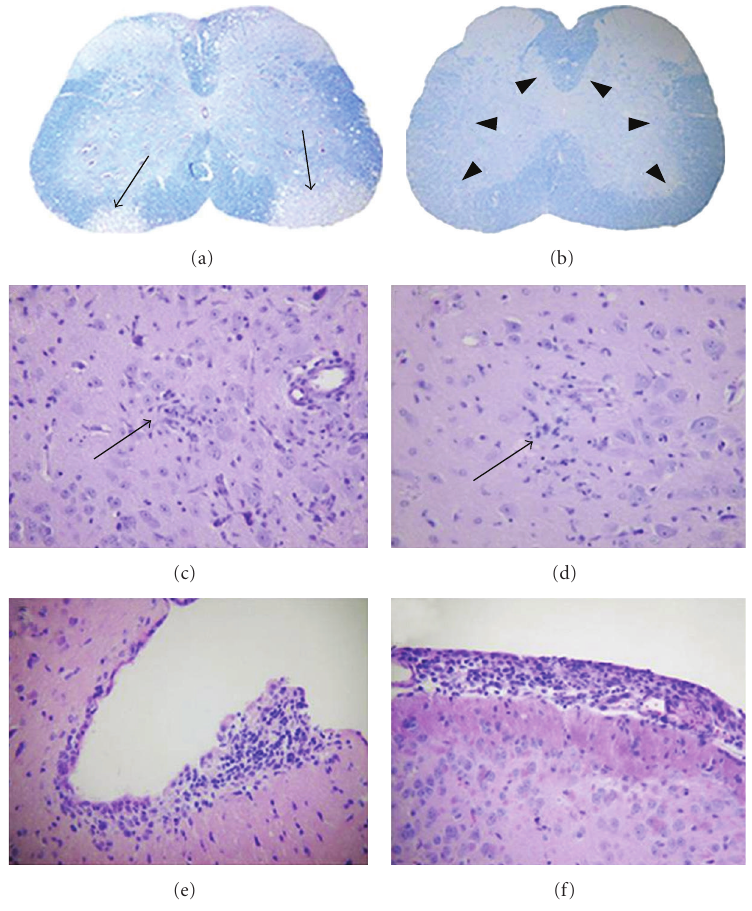
Figure 12: CNS pathology of EGFP expressing MHVs. (a, b) Demyelination: luxol fast blue-stained spinal cord sections of mice infected with RSA59 EGFP (a) or RSMHV2 EGFP (b), at day 30 post infection. Thin arrows indicate a region of demyelination, and the arrowheads indicate normal myelinated area of white matter. (c, d) Encephalitis: microglial nodules: Hematoxylin- and Eosin-stained sections from the basal forebrain of mice infected with EGFP tagged MHVs at day 7 post infection. Arrows indicate the microglial nodules (microglia with elongated nuclei) and lymphocytes in the vicinity of neurons in mice infected with RSA59 EGFP (c) and RSMHV2 EGFP (d). (e, f) Meningitis. Hematoxylin- and eosin-stained sections from the basal forebrain of mice infected with EGFP tagged MHVs at day 7 post infection: RSA59 EGFP and RSMHV2 EGFP . In all cases, there is a brisk leptomeningeal lymphocytic inflammatory infiltrate. An original magnification for (a, b) is 20x and (c–f) is 200x. (adapted from the work of